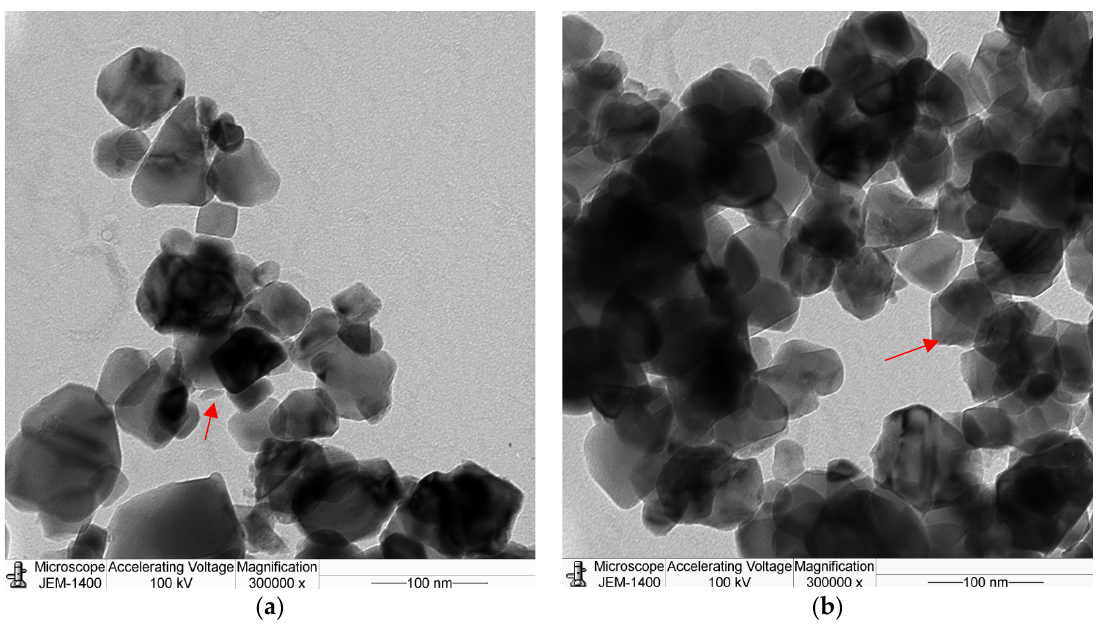
Figure 3. Transmission electron microscopy images of green TiO 2 nanoparticles. ( a ) irregular ( b ) hexagonal in shape.